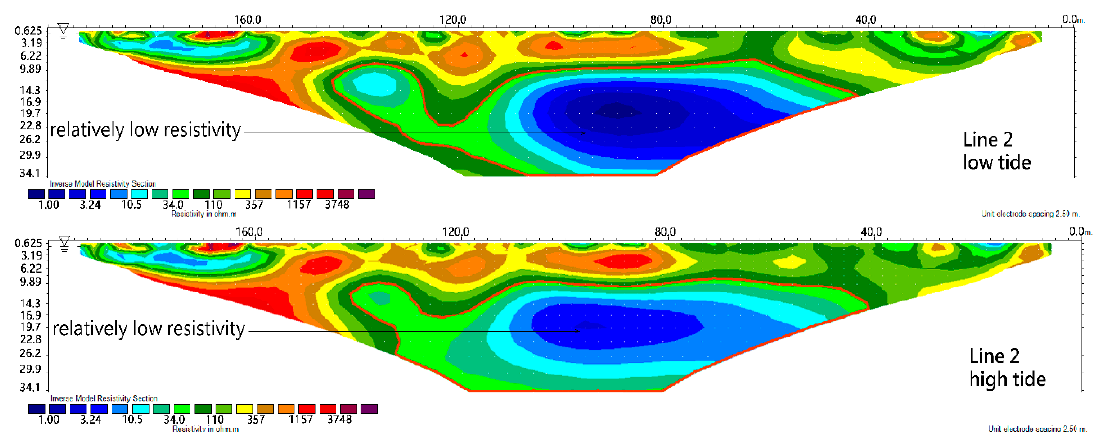
Figure 10. Comparison diagram of tide rising of L2 Measuring Line.